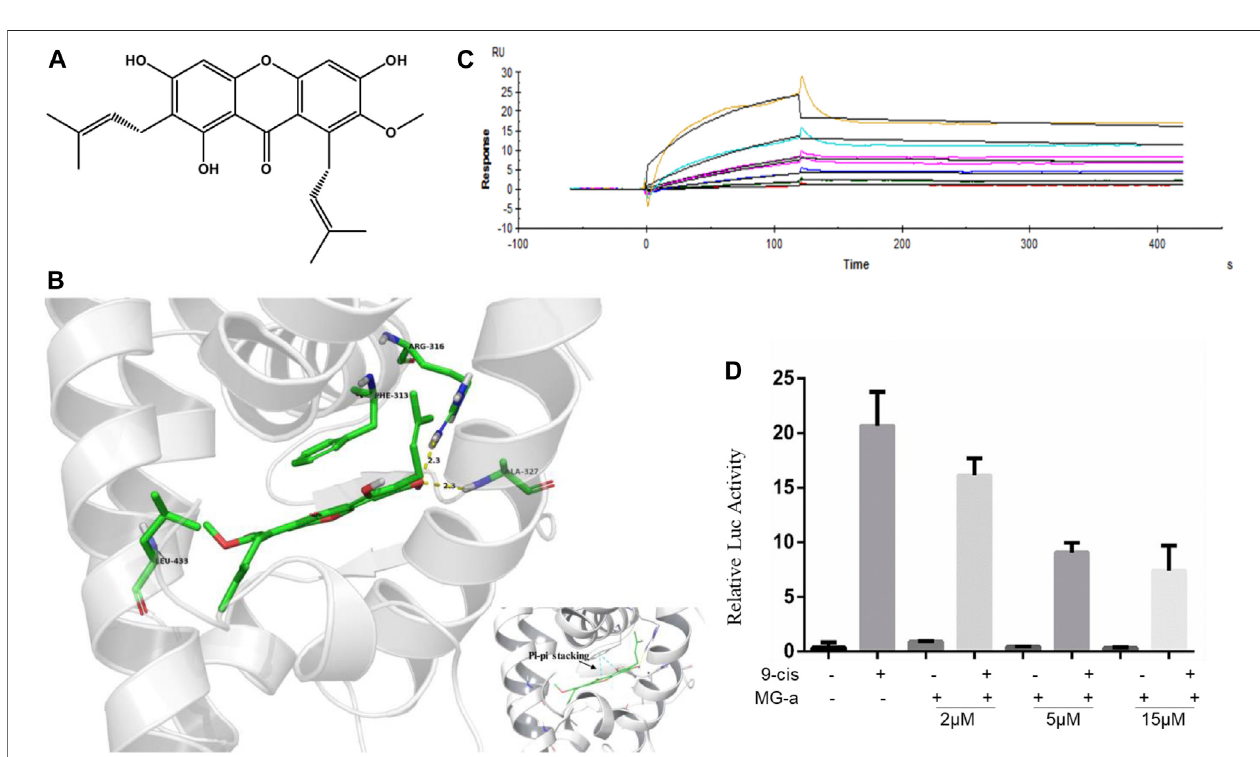
FIGURE 3 | α -Mangostin induces apoptosis by targeting RXR α . (A) The structural formula of α -Mangostin. (B) The results of molecular docking: α -Mangostin interacts with amino acid residues Arg-316, Ala327, and Leu-433 of RXR α LBD. A pi-pi stacking is formed with amino acid residue Phe-313. (C) Antagonistic effect of α -Mangostin (2, 5, 15 μ M). 293 Tcells transfected with PBind-RXR/LBD and PG5 expression vector were treated with or without 10 – 7 mol/L 9-cisRA in the absence or presenceofdifferentconcentrationsof α -Mangostin.Reporter activities weremeasured and normalized.Oneofthreeindependent experiments isshown. (D) SPR analysis of the interaction of MG-a with RXR α ( α -Mangostin solution was injected into the RXR-LBD protein channel and blank channel at seven concentrations (0.625, 1.25, 2.5, 5, 10, 20, and 40 nM).